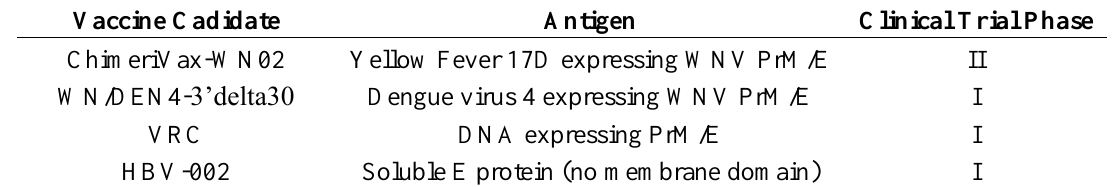
Table 2. West Nile virus vaccine candidates under clinical